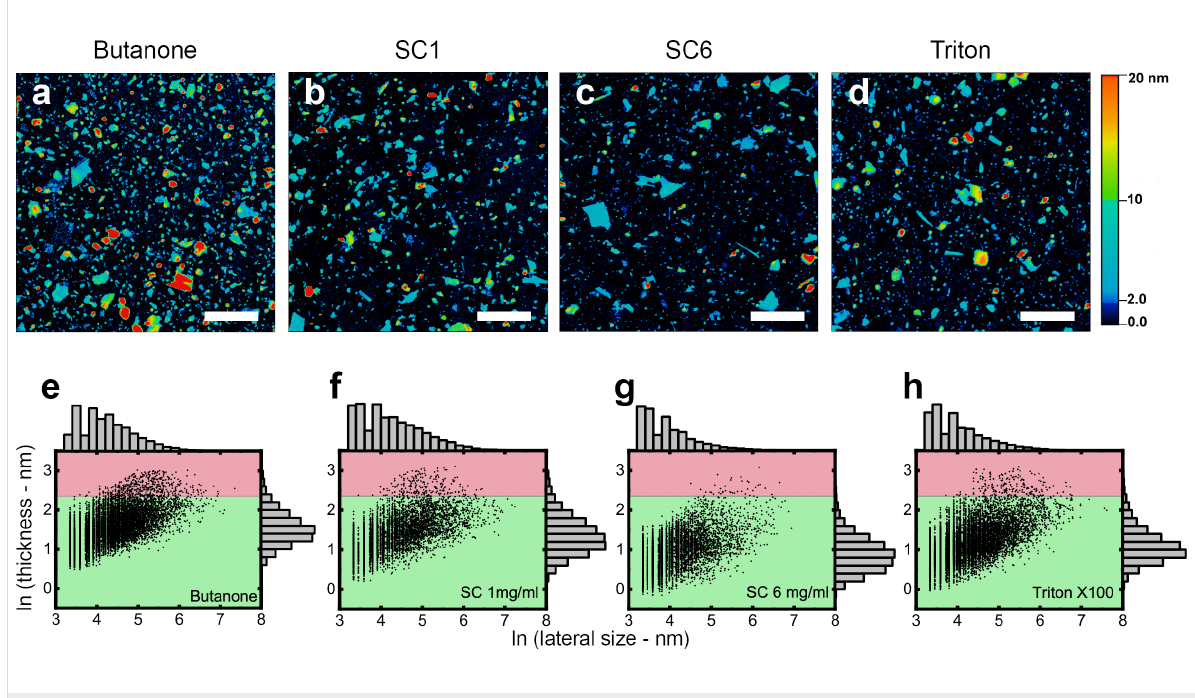
Figure 2: Atomic force microscopy images of the samples produced employing the four different media under investigation. (a–d) AFM images of samples expoliated with butanone, sodium cholate at 1 mg/mL, sodium cholate at 6 mg/mL, and triton-X100, respectively. The scale bars are 1 μ m. (e–h) Statistics from the four different samples in the same order as the AFM images. The top histograms indicate the lateral size distribution, where- as the side histograms show the thickness distribution. The green region marks flakes that are less than 10.5 nm thick while pink represents flakes thicker than 10.5 nm.